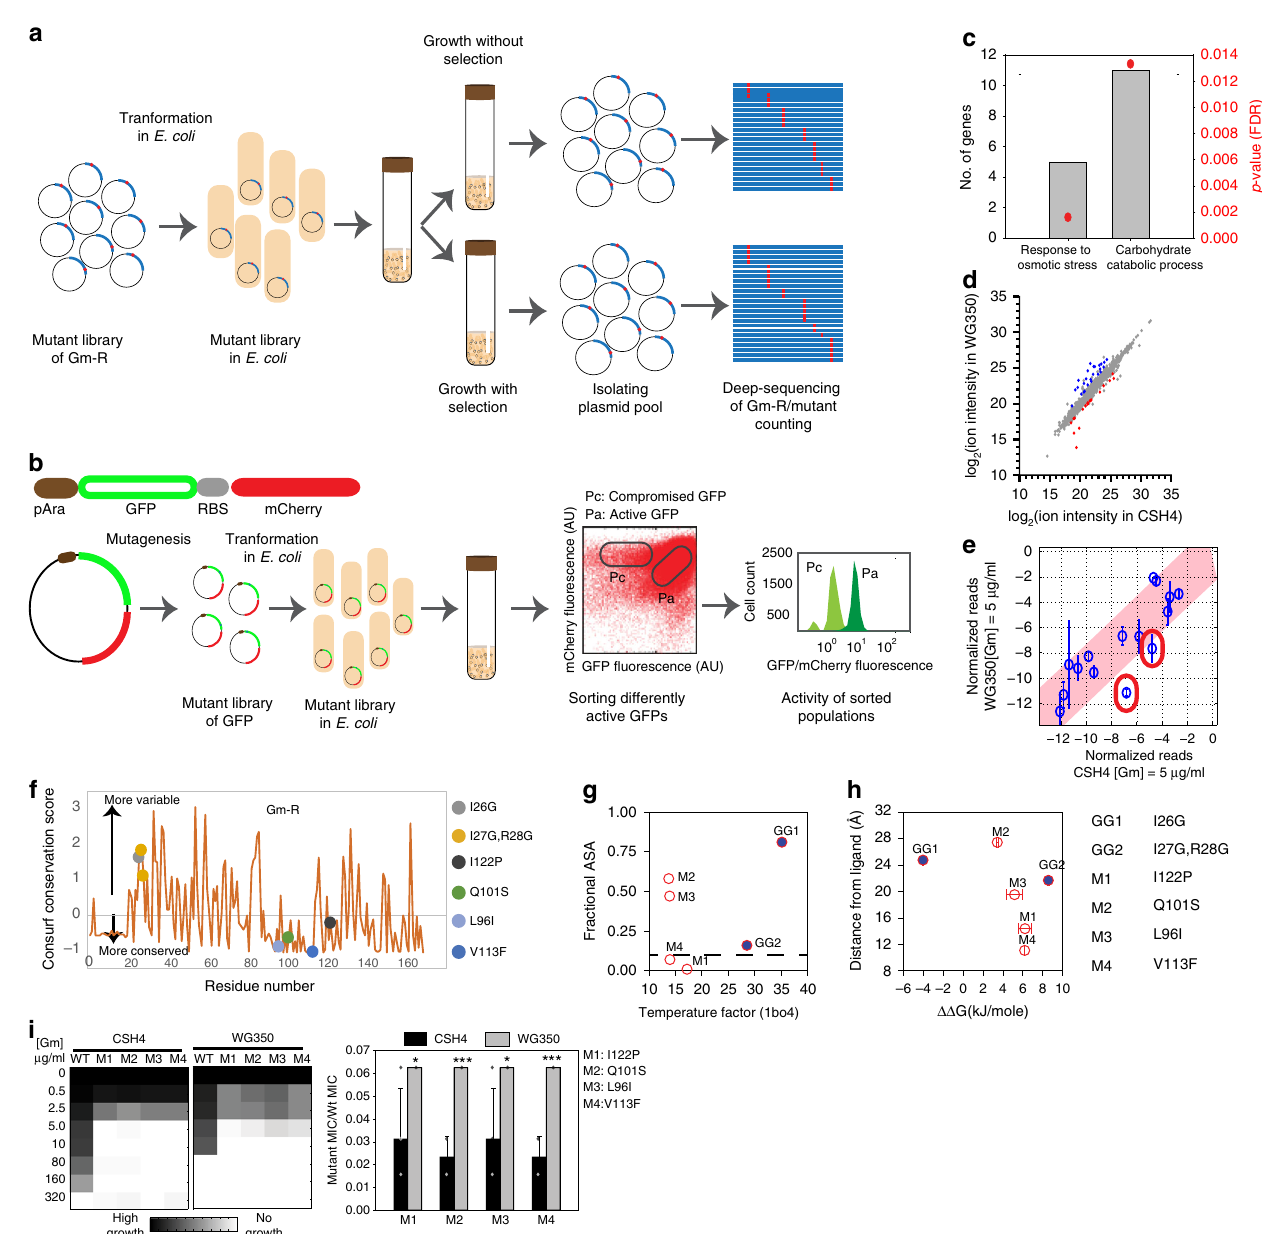
Fig. 2 Genetic alteration in cellular metabolism changes mutational buffering. a Schematic for activity assay for glycine-doublet substitution library of Gm-R. Gm-R activity is inferred from competitive fi tness of the mutants under gentamicin selection and deep-sequencing. b Schematic for activity assay of GFP-mutant library. An arabinose inducible promoter drives the bicistronic construct of GFP and mCherry. GFP is mutated using random mutagenesis. GFP mutants are sorted into population of compromised mutants (Pc) and active mutants (Pa) based on GFP Fluorescence. c Gene Ontology (GO) classes upregulated in WG350 transcriptome with respect to CSH4 shown as fold enrichment on the left-axis and Benjamini-Hochberg FDR corrected p -values obtained using DAVID 63 on the right axis from two biological replicates. d Comparison of metabolites in WG350 and CSH4 using untargeted metabolomics. Colored circles represent signi fi cantly different metabolites between CSH4 and WG350 obtained using paired 2-sided Student ’ s t -test ( p -value < 0.05, fi ve biological replicates for each sample). e Mean of normalized read counts of Gm-R GG-mutant library at comparative selection pressure of gentamicin (Gm) from two biological replicates. Pink shaded area marks 99% con fi dence interval. Mutants marked in red show lower read counts in WG350 than in CSH4. f Conservation score (calculated using Consurf) for each residues that are mutated in the clones studied. g Fractional ASA (calculated using VADAR) of the mutated residues against the temperature factor of the residues obtained from PDB fi le 1BO4 (left panel). h Distance of the residues mutated from the ligand plotted against the predicted alteration in protein stability. Error bar represents standard deviation from three replicates (calculated using FoldX). i Heatmap representing growth of Gm-R mutants in WG350 and in CSH4 along with Wt Gm-R in increasing gentamicin (Gm) concentration (left panel). MIC of each mutant normalized with respect to Wt Gm-R in the respective strains (right panel). Mean is plotted with standard deviations as error bars from four biological replicates. Signi fi cance is calculated using 2-sided Students ’ t -test with respect to CSH4 (* p -value M1:0.03, M3:0.03; *** p -value M2:0.0001, M4:0.0001). Also see Supplementary Fig. 1 (Source data are provided as source data fi le Fig.